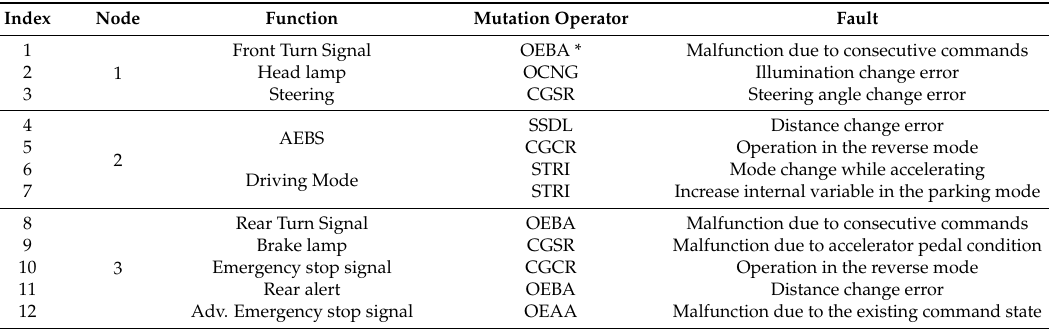
Table 3. List of fault injection by the selected mutation